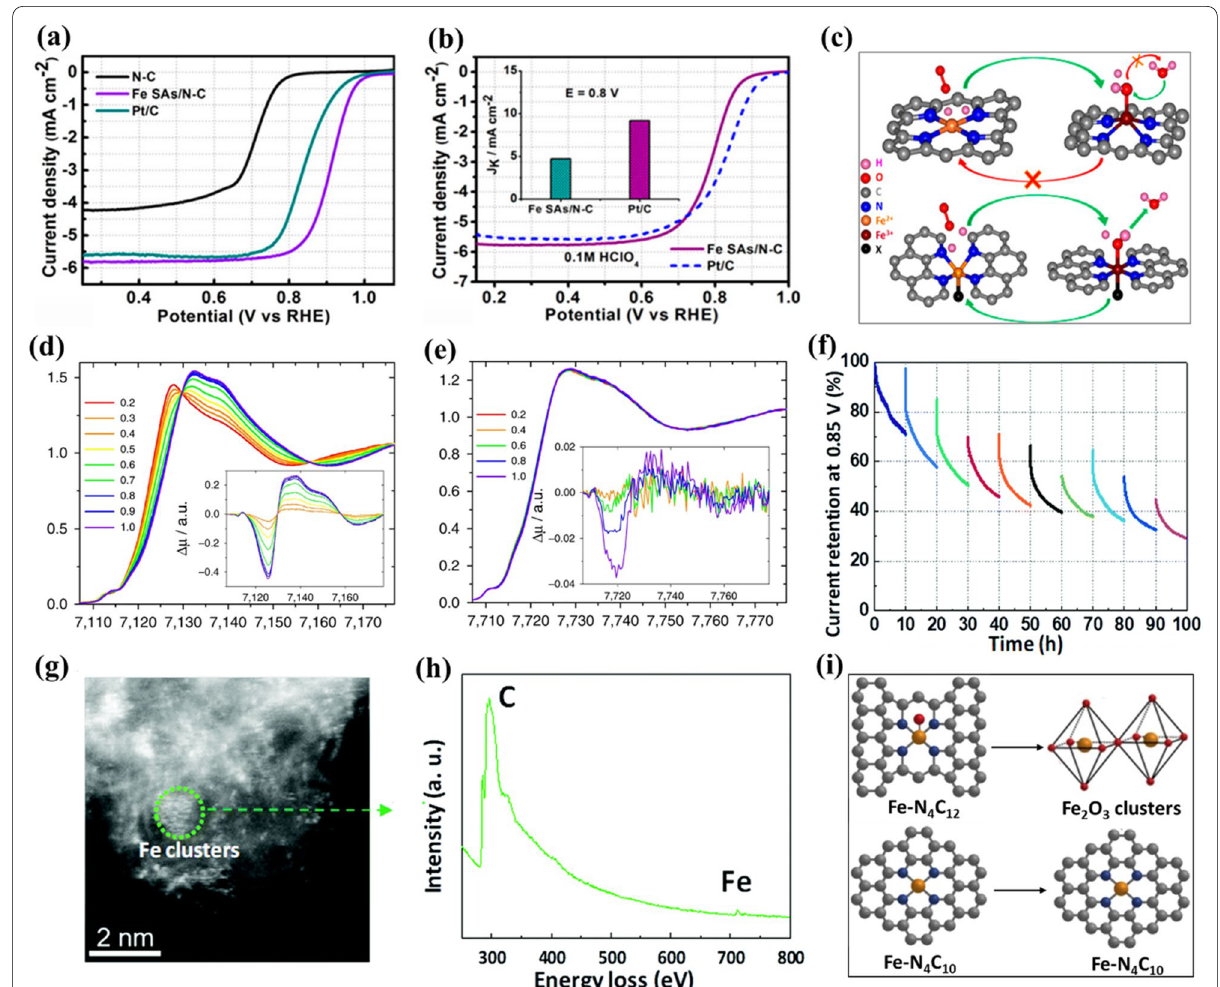
Fig. 3 a LSV curves of N‑C, Fe SAs/N‑C and Pt/C catalysts in O 2 ‑saturated 0.1 M KOH. b LSV curves of Fe SAs/N‑C and Pt/C catalysts in O 2 ‑saturated 0.1 M HClO 4 . c Schematic illustration of Fe‑N switching behaviour of Fe‑N 4 ‑C x models with/without axially bound O(H) ads . Operando X‑ray absorption near‑edge structure (XANES) spectra of d Fe‑N 4 and e Co‑N 4 catalysts (insets: differential Δµ XANES spectra). f Durability testing of Fe‑N 4 catalyst at 0.85 V for 100 h. g High angle annular dark field scanning transmission electron microscopy (HAADF‑STEM) image and h electron energy